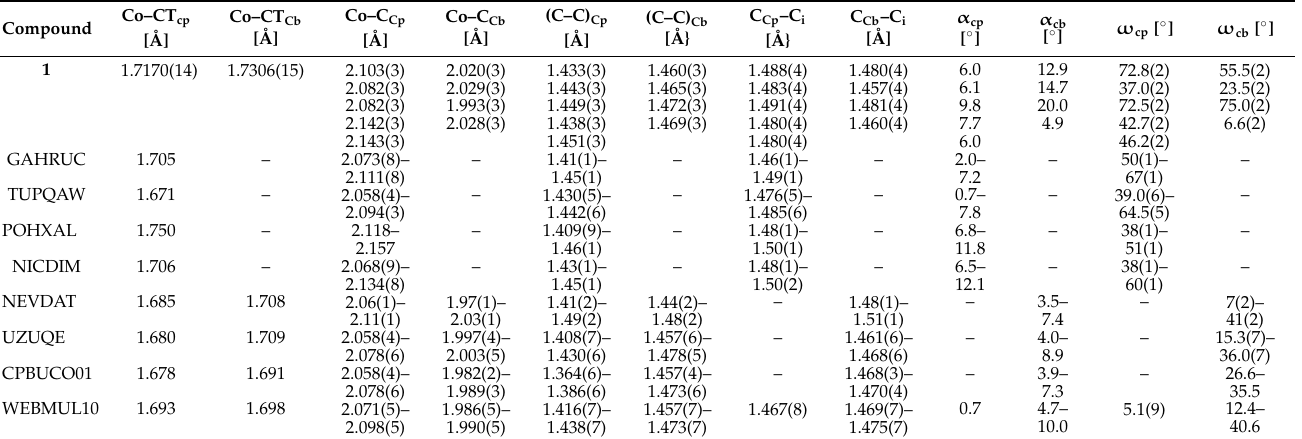
Table 1. Important bond parameters of compound 1 in comparison with several structurally re- lated